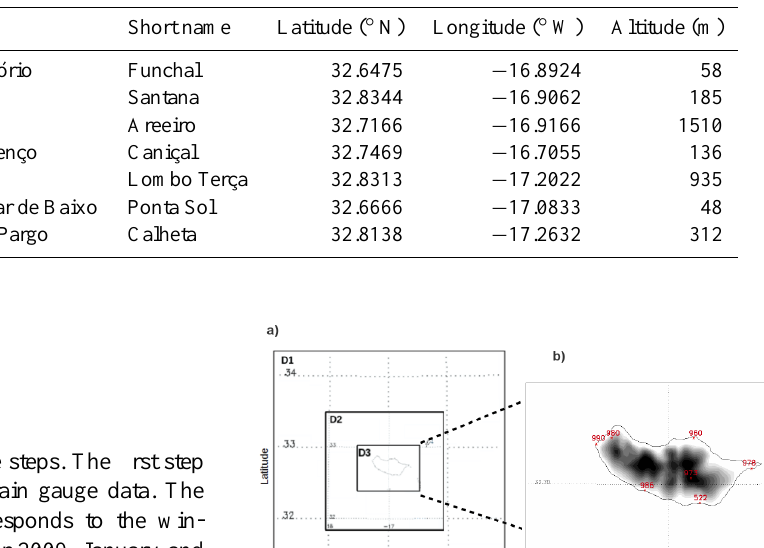
Table 1. Identification of the meteorological stations used in the work, presenting the number, name, location and altitude.